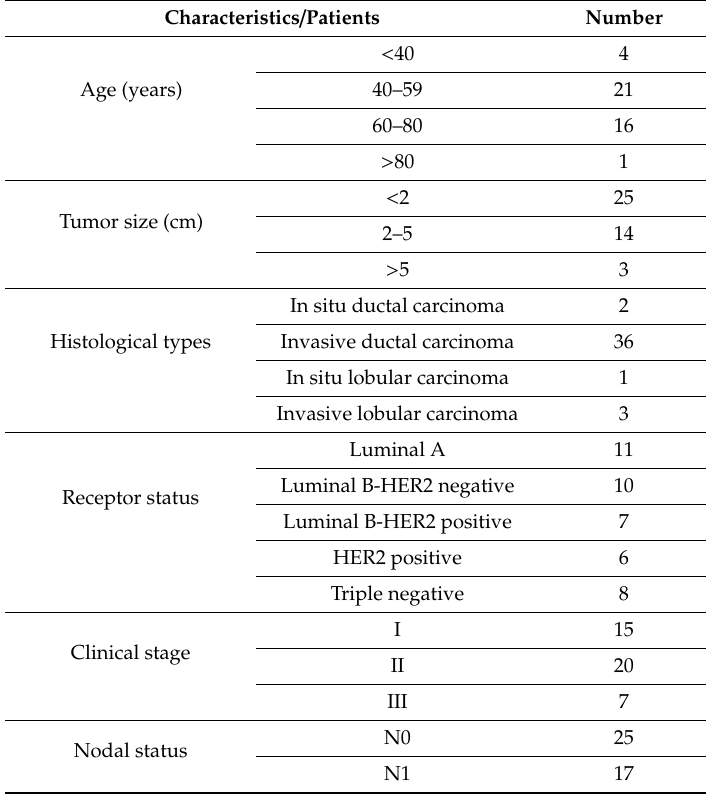
Table 1. Clinical features of breast cancer